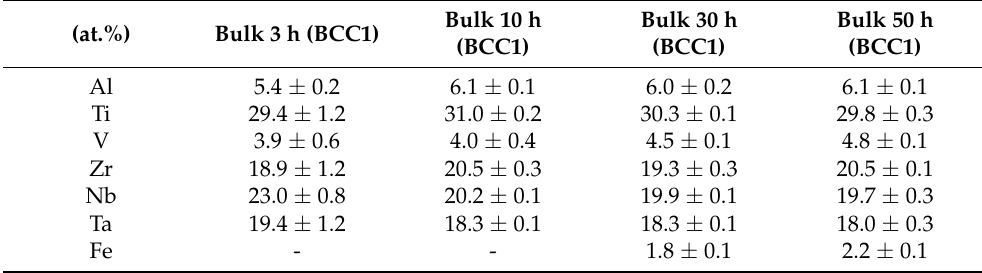
Table 3. Chemical compositions in at.% of the BCC matrix of sintered bulks subject to different milling times performed by SEM/EDS.